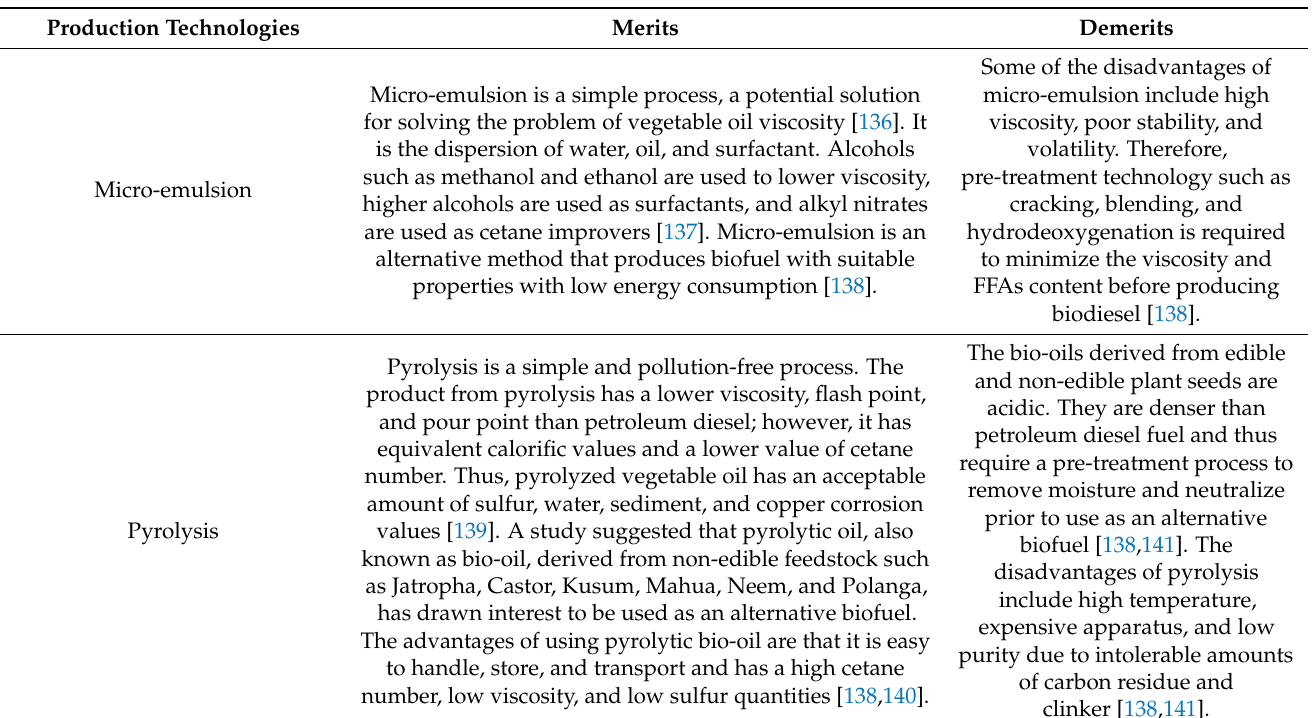
Table 6. Merits and demerits of using various biodiesel production technologies